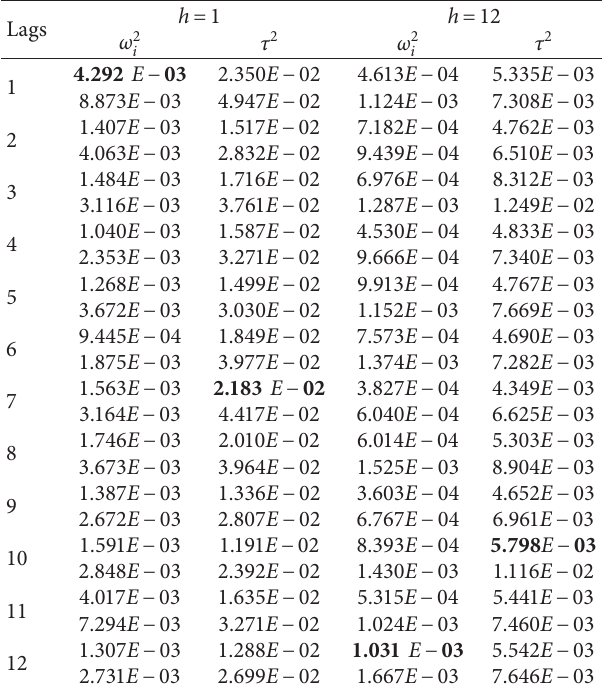
Note. The bold text noted indicates relatively larger value among all ω 2 i and τ 2 , while the underlined text represents values relatively smaller ones.